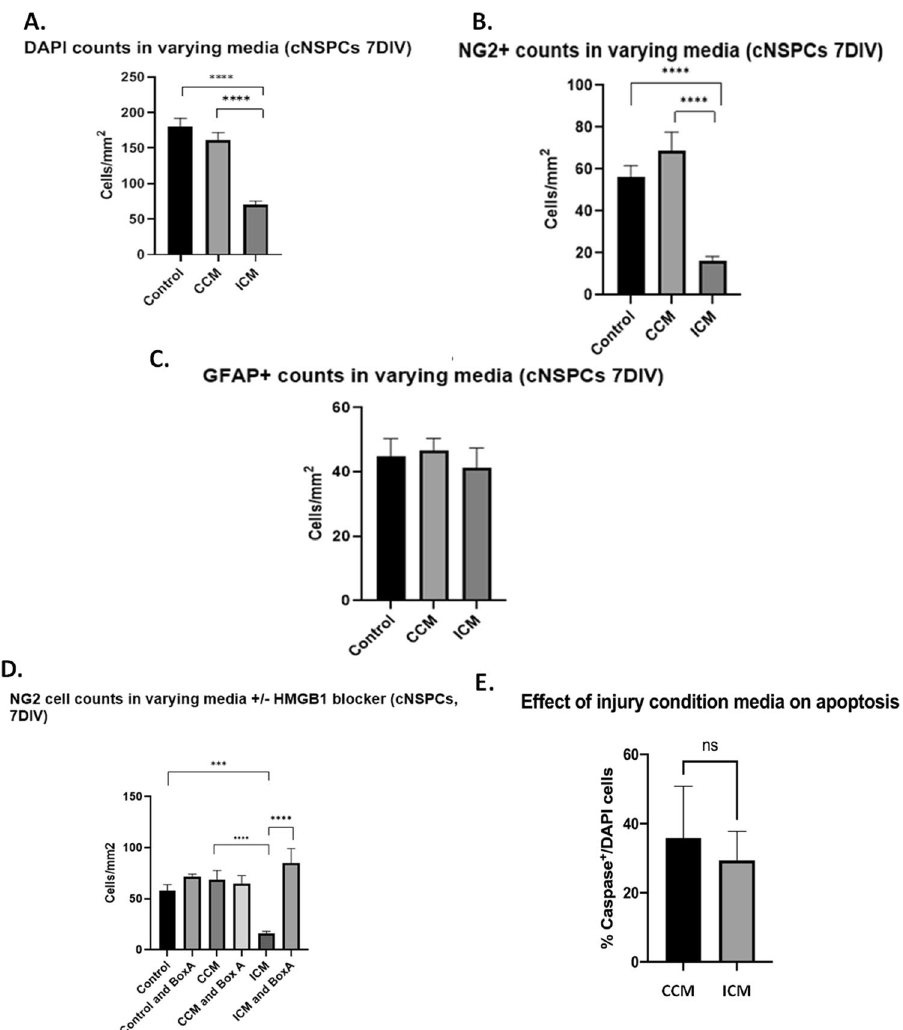
Figure 2. Post injury-released HMGB1 acts via TLR2/4 receptors to reduce the numbers of oligodendrocyte progenitor cells in vitro . ( A ) DAPI cell counts were significantly reduced in the presence of injury conditioned media, with no difference between control cultures and control conditioned medium. ( B ) NG2 + cells were significantly reduced in the presence of injury conditioned media compared to both control and control conditioned media. ( C ) There was no difference in GFAP + cell counts in any of the conditioned media experiments. ( D ) Addition of BoxA, at a concentration of 100 ng/ml, did not affect NG2 + cell counts in control or control conditioned media conditions. However, BoxA rescued NG2 + cell counts in the presence of ICM to levels akin to the counts of control cultures ( p < 0.0001). ( E ) Addition of ICM did not affect cell death in our cultures, assessed as the proportion of Caspase + cells/DAPI + . For comparisons between two conditions, two- tailed student’s T-test was used, and for multiple different conditions, a two ‐ way ANOVA and one-way ANOVA with Dunnett’s multiple comparison test was used. p values of < 0.05 were considered significant (* p < 0.05; ** p < 0.01; *** p < 0.001; **** p < 0.0001). cNSPCs = rat cortical neural stem cell progenitors; CCM = controlled conditioned medium; ICM = injury conditioned medium; DIV = days in